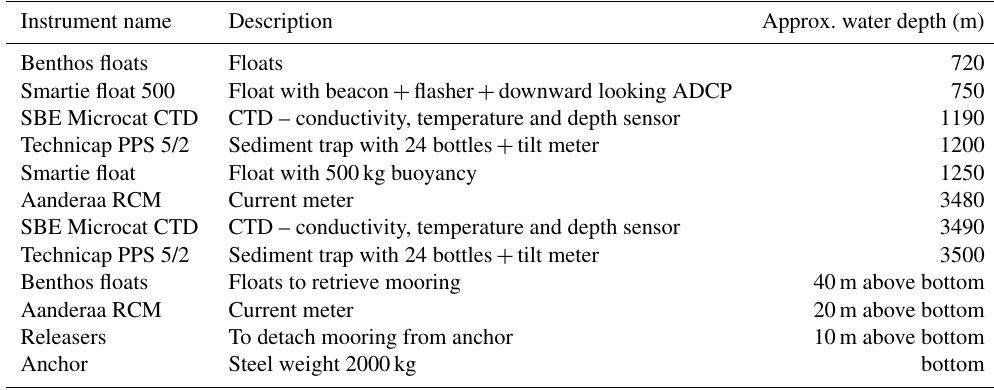
Table 1. Layout of moorings’ instruments as an example of sampling site